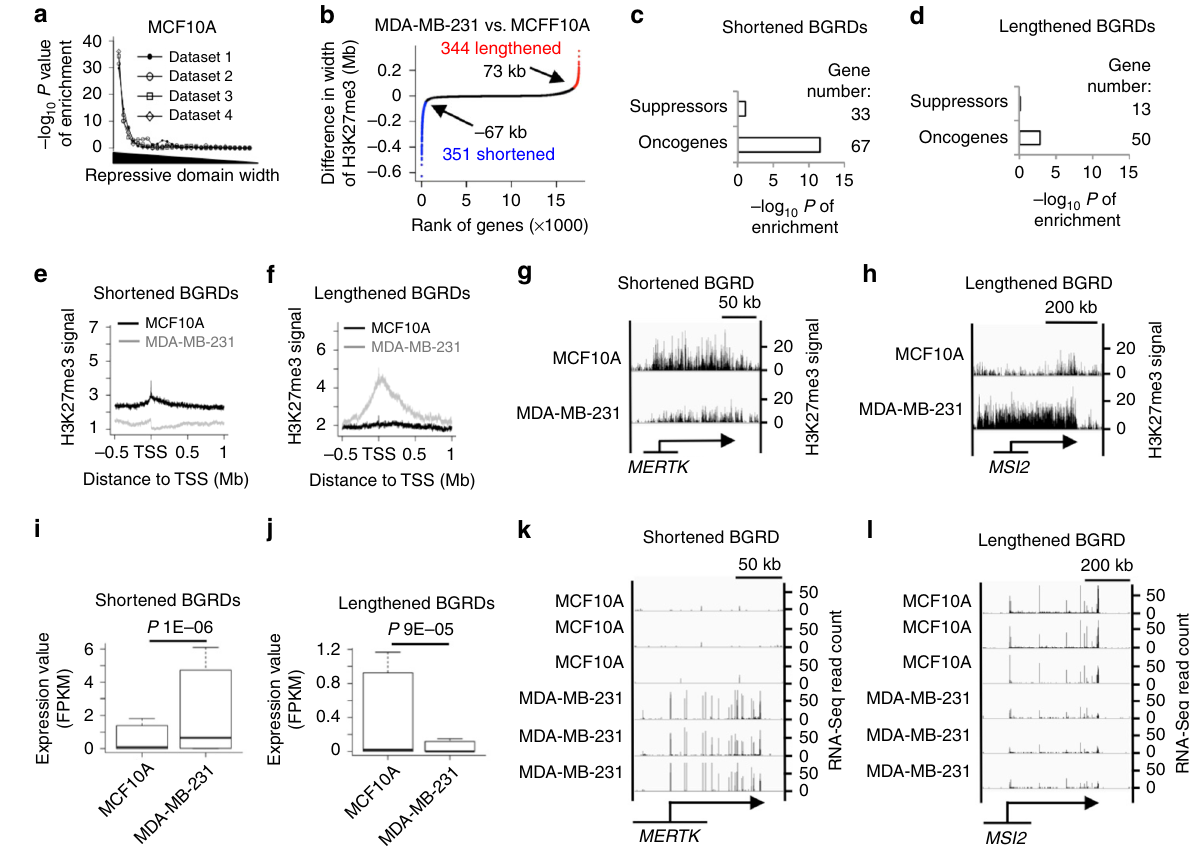
Fig. 5 Disruption of BGRD is associated with upregulation of oncogenes in breast cancer cells. a Enrichment level of oncogenes plotted against width of repression domain in breast epithelial cell lines. Genes were ranked by H3K27me3 width and divided into groups that each contains 1500 genes, with two neighboring groups in the rank having 500 genes in common. A dot in each curve indicates the enrichment level ( Y -axis) of one of these groups ( X -axis) in the oncogenes. b Cumulative plot of difference in H3K27me3 width between the cells MDA-MB-231 and MCF10A. Genes were ranked by difference in H3K27me3 width from the most shortened (blue) at the left side of X -axis to the most lengthened (red) at the right side. Enrichment level and number of oncogenes or tumor suppressors in genes that show shortening ( c ) or lengthening ( d ) of BGRDs in MDA-MB-231 relative to MCF10A cells. Average ChIP- Seq signal of H3K27me3 around TSS of genes that show shortening ( e ) or lengthening ( f ) of BGRDs in MDA-MB-231 relative to MCF10A. g , h ChIP-Seq signal of H3K27me3 at example genes in the MDA-MB-231 and MCF10A cell lines. Arrows indicate gene loci. Gene names were indicated at the bottom. Y -axis scale at the right side indicates ChIP-Seq signal strength. Boxplot for expression values of genes that show shortening ( i ) or lengthening ( j ) of BGRDs in MDA-MB-231 relative to MCF10A, n (lengthened) = 344 and n (shortened) = 351. Box plots: center line is median, boxes show fi rst and third quartiles, whiskers extend to the most extreme data points that are no more than 1.5-fold of the interquartile range from the box. RNA-Seq signal at example genes that display shortening ( k ) or lengthening ( l ) of BGRDs in MDA-MB-231 relative to MCF10A cells. Arrows indicate gene loci. Gene names were indicated at the bottom. Y -axis scale at the right side indicates RNA-Seq signal. P values determined by one tail Fisher ’ s exact test a , c , d or one tail Wilcoxon test i , j . Source data are provided as a Source Data fi